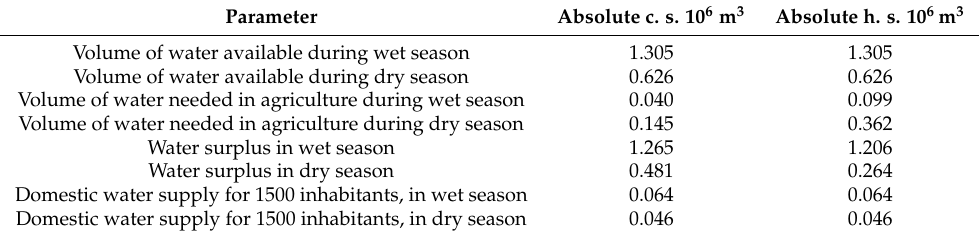
Table 8. Summary of agricultural and domestic water volumes, and water availability at the basin scale. Volumes are calculated for the current state (c. s.) considering a cultivated surface of 0.474 km 2 , and for a hypothetical state (h. s.) in which also abandoned terraces are cultivated for a total of 1.184 km 2 of cultivated surface. See Table 2 for details. Water volumes are expressed in 10 6 m 3